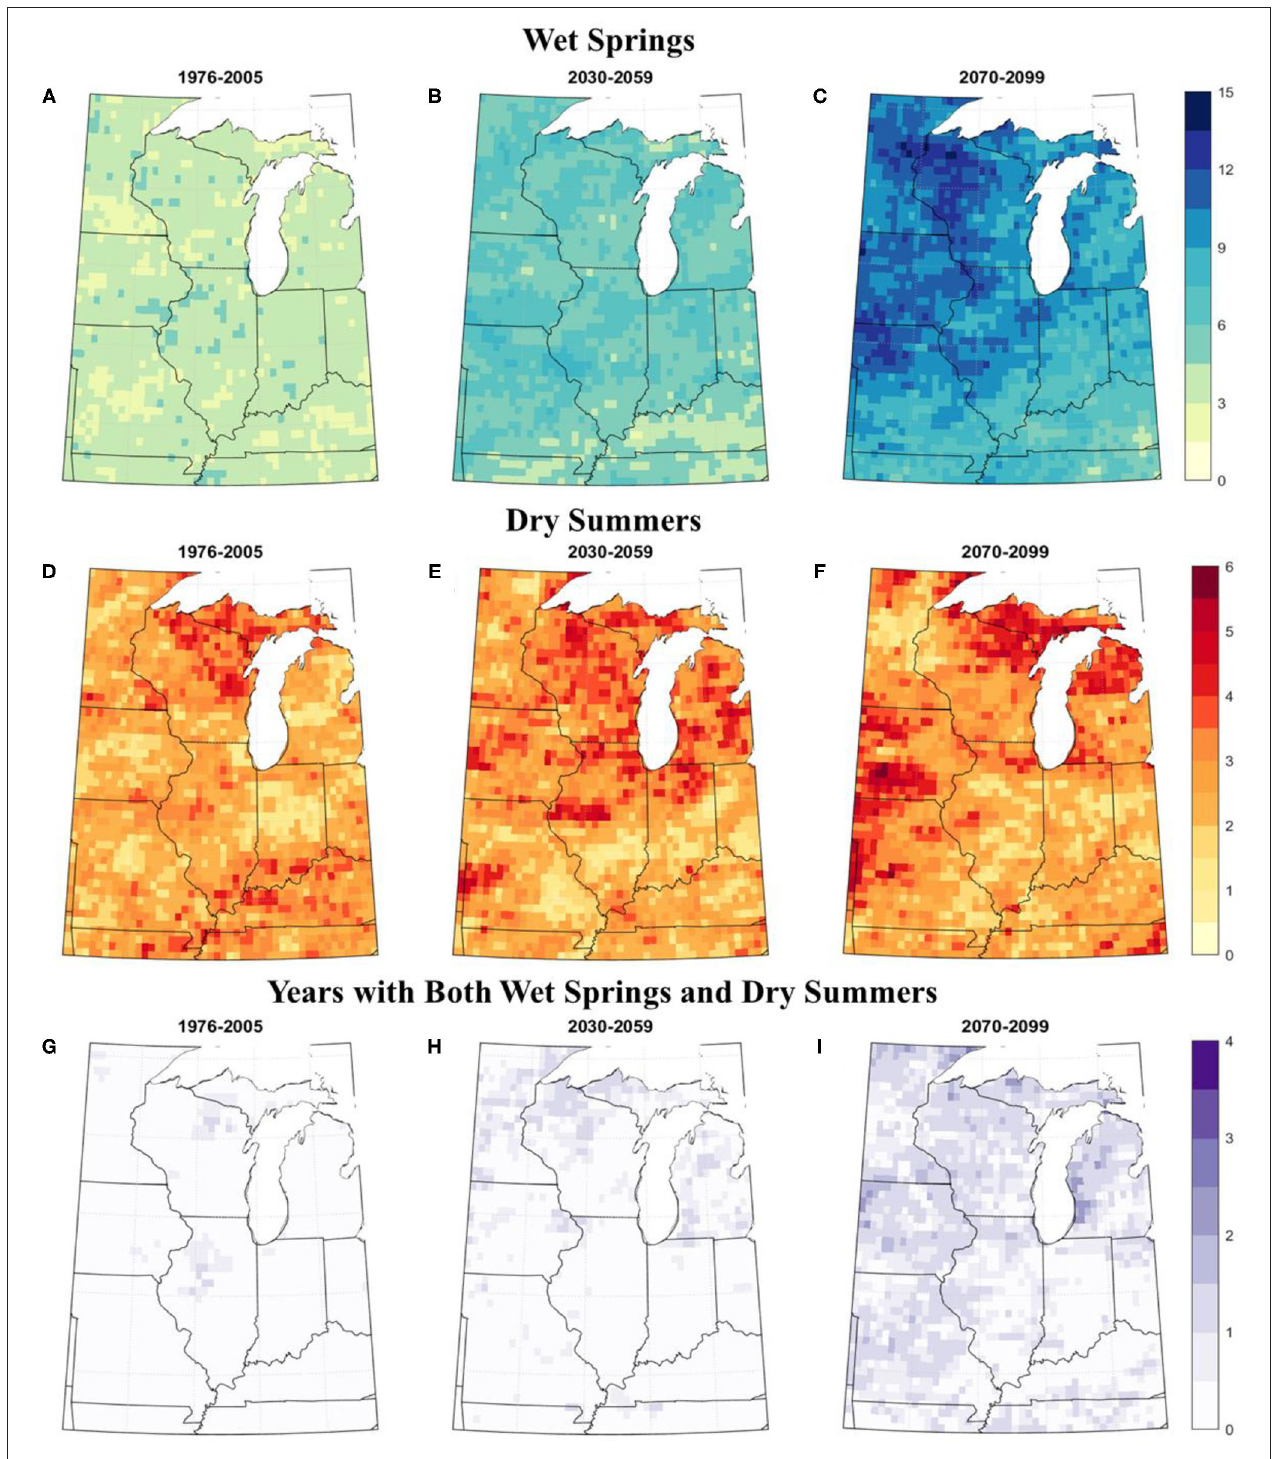
FIGURE 10 | The number of wet springs (A–C) , dry summers (D–F) , and years with both (G–I) during each period based off the multi-model ensemble median seasonal totals for the NA-CORDEX historical period 1950–2005.